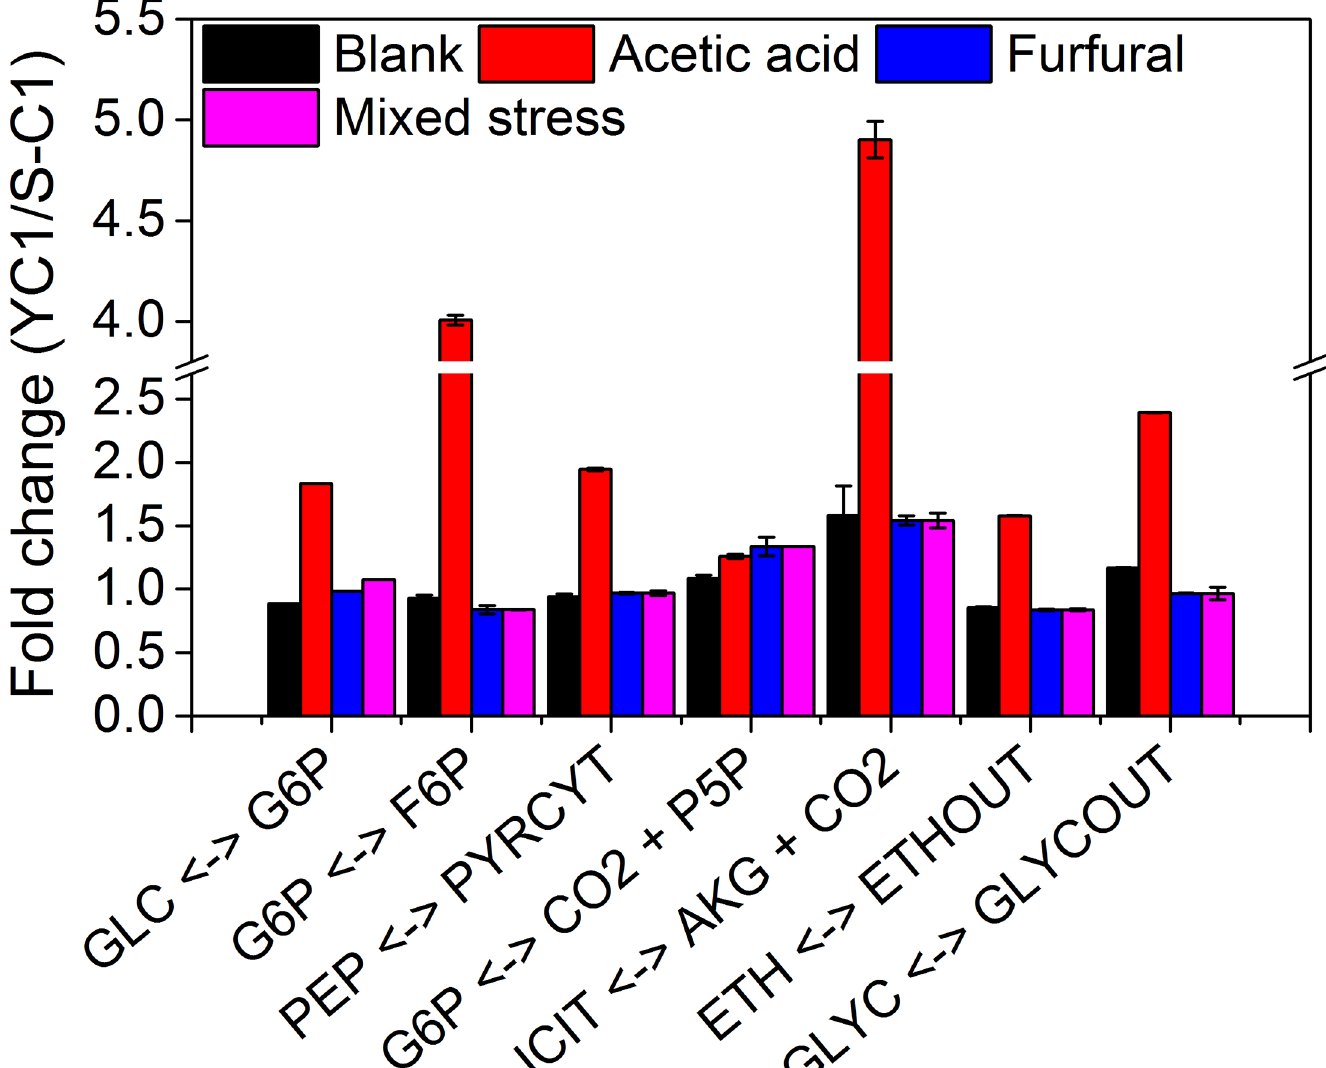
Fig 3. Fold changes of key fluxes between the S-C1 and YC1 strain under different stress conditions. Abbreviation: GLC, glucose; G6P, glucose- 6-phosphate; F6P, fructose-6-phosphate; PEP, phosphoenolpyruvate; PYRCYT, pyruvate in cytosol; P5P, ribulose 5-phosphate; ICIT, isocitrate; AKG, α - ketoglutarate; ETH, ethanol; ETHOUT, extracellular ethanol; GLYC, glycerol; GLYCOUT, extracellular